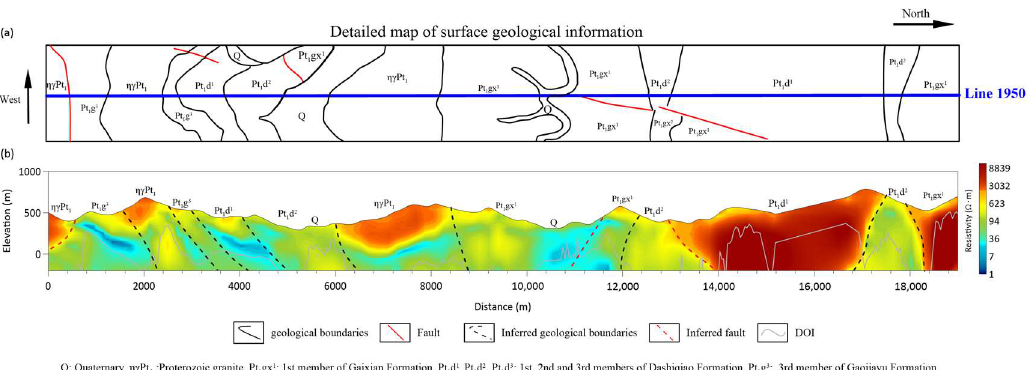
Figure 9. The detailed geological information near the line 1950 and the inversion profile result. ( a ) The detailed geological map near line 1950. The blue line represents the position of line 1950. ( b ) Resistivity section of line 1950.